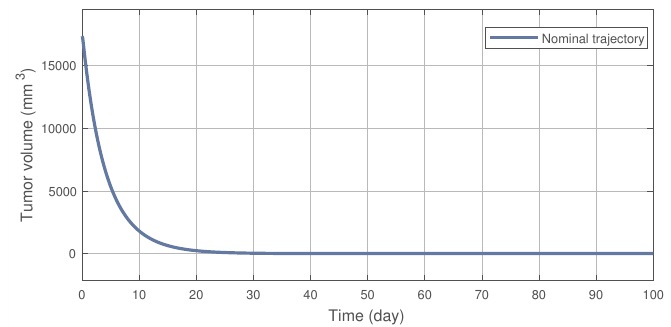
Figure 2. The nominal trajectory produced by the NMPC controller.